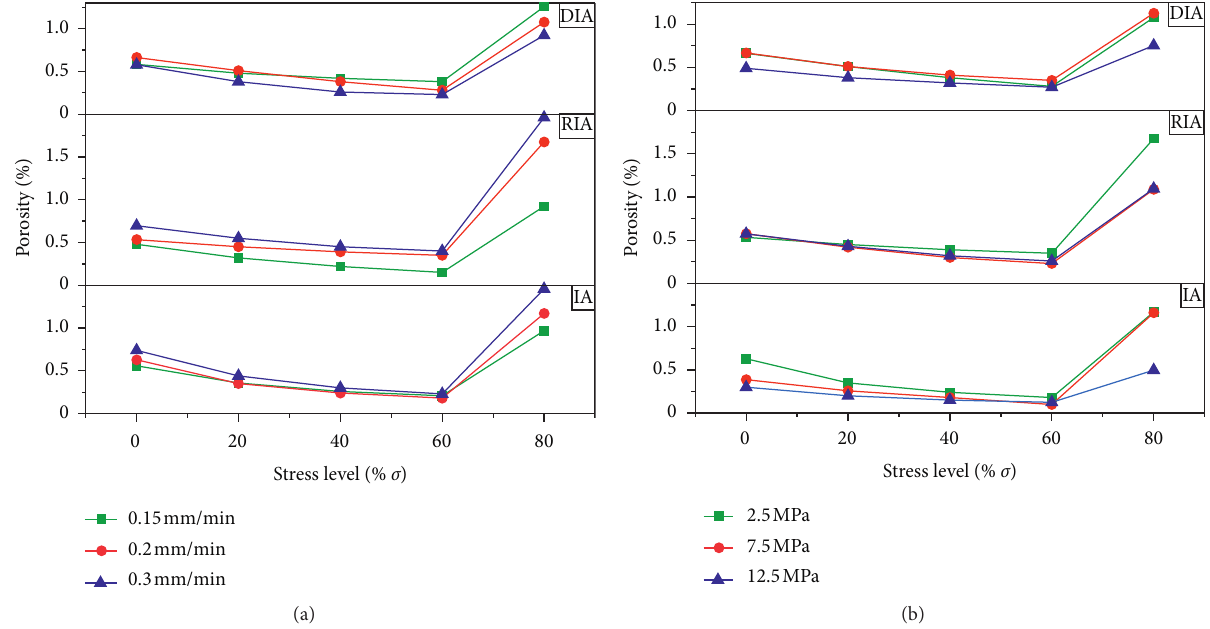
Figure 7: Porosity changes at different loading rates and initial peak stresses for each method: (a) different loading rates ( σ different initial peak stresses ( v � 0.2